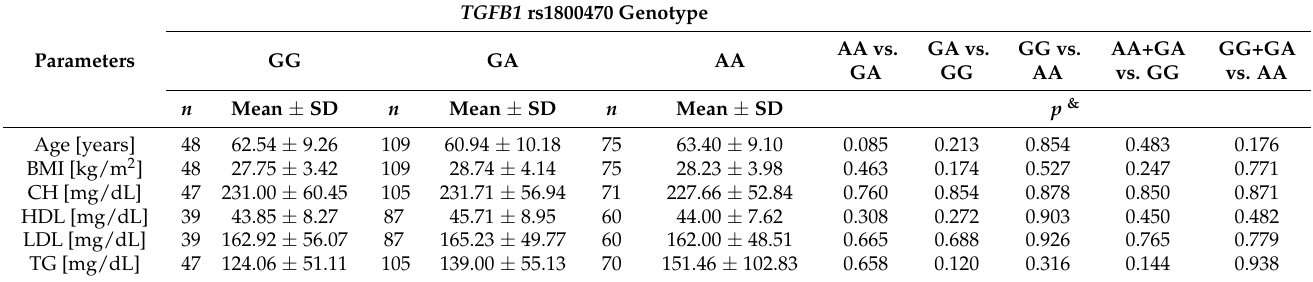
Table 6. Associations between the clinical parameters of patients with unstable angina and the TGFB1 rs1800470